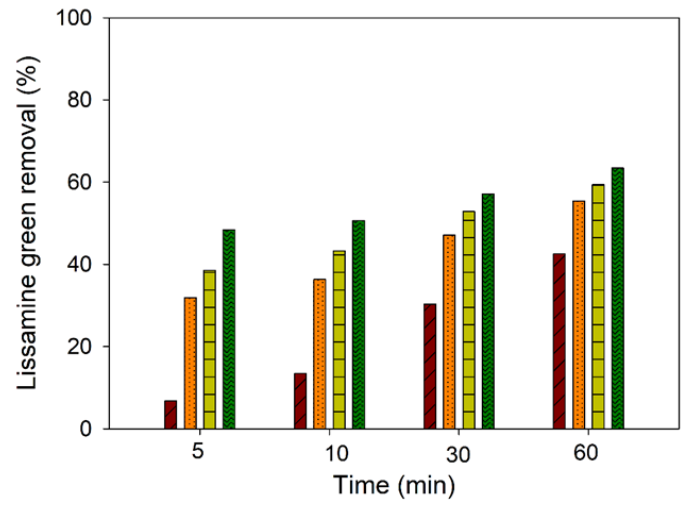
Figure 4. Effect of iron concentration on lissamine green removal: Fe 2+ = 0 mM (diagonal lines, red), 0.1 mM (dots, orange), 0.2 mM (horizontal lines, lime), 0.3 mM (zigzag lines, green). Experimental conditions: lissamine green = 7.5 mg·L −1 , PS = 1 mM.